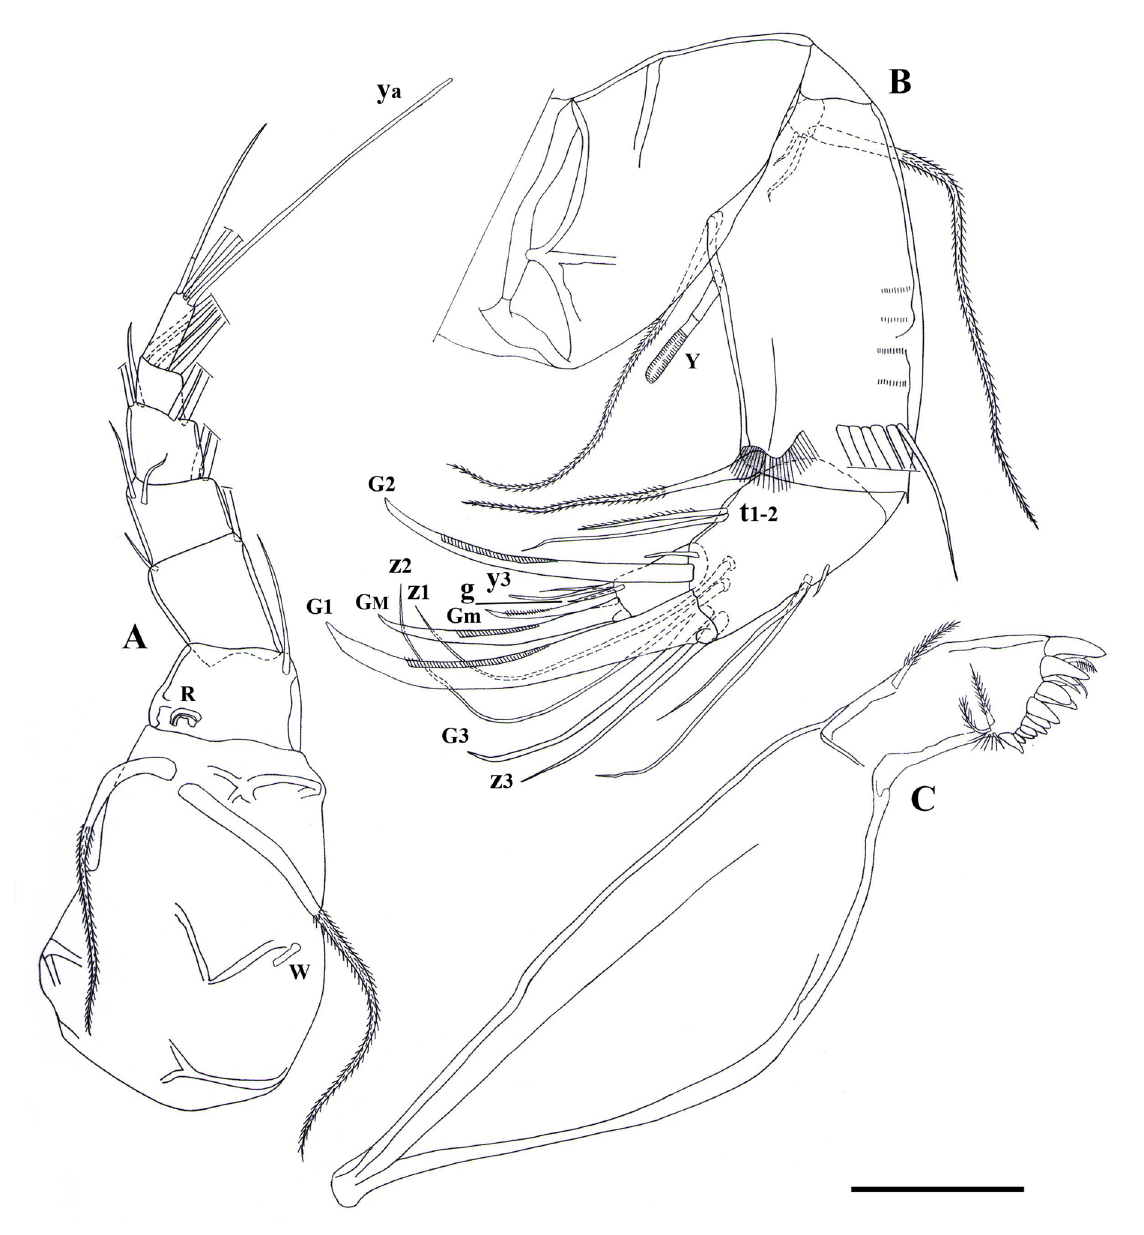
Fig. 12. Siamopsis khoratensis gen. et sp. nov., ♀ (MSU-ZOC.204). A . A1. B . A2. C . Md coxa. Scale bar: 50